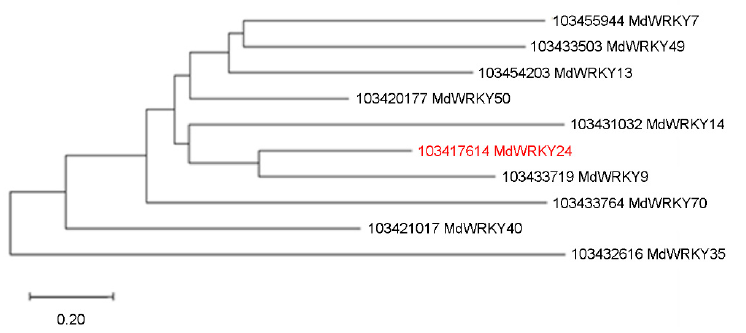
Figure 3. Systematic evolution analysis of ten MdWRKY families with significantly differentially expressed genes. The place marked in red is the target gene. The number on a branch represents the frequency parameter for that branch; higher values represent higher confidence.